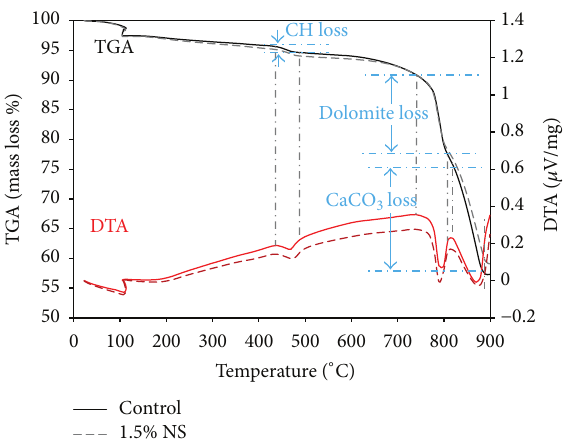
Figure 10: TGA/DTA plots of reference and 1.5% NS addition into concrete with w / b = 0.65 versus temperature range from 25 to 900 ∘